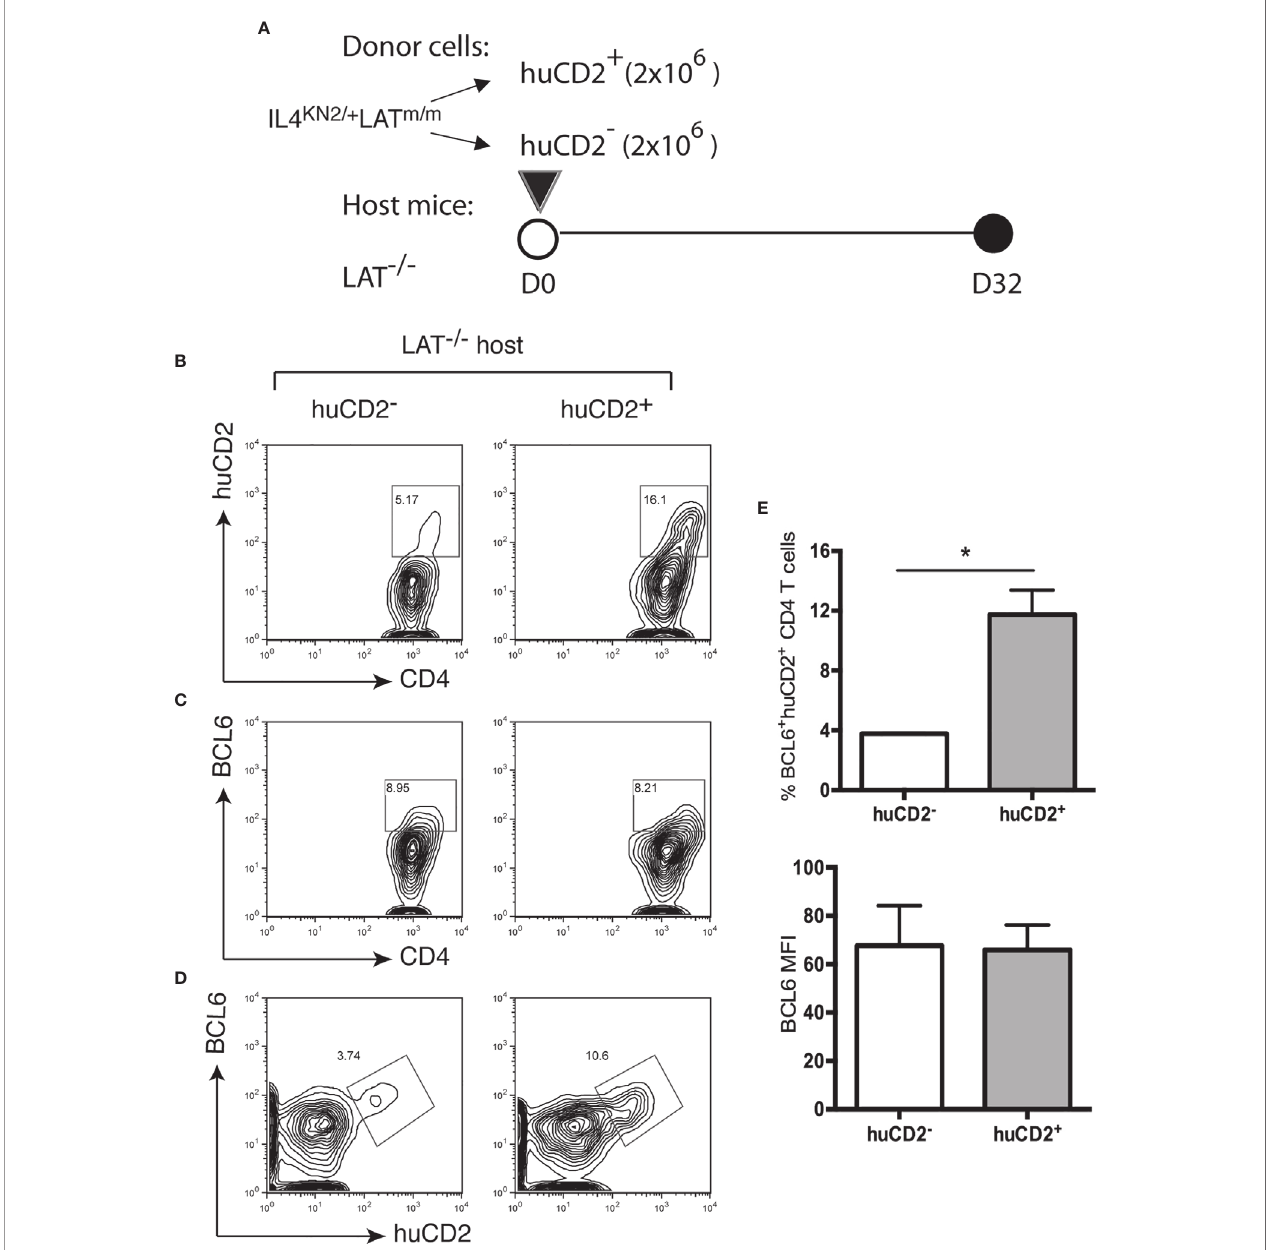
FIGURE 6 | Instability of the LATY136F Tfh signature. (A) 1.5x10 6 huCD2 + and huCD2 - CD4 + T cells were sorted from IL4 KN2+ LAT m/m mice and transferred into LAT -/- mice. Mice were sacri fi ced 8 weeks later and analyzed by FACS. CD4 and Thy1.2 were used to pre-gate on transferred T cells. (B) Representative fl ow plots of CD4 verse huCD2. (C, D) Intracellular staining for BCL6. (E) The percent of BCL6 + huCD2 + cells of total CD4 + T cells and BCL6 gMFI pre-gated on BCL6 + huCD2 + CD4 + T cells. Two-tailed t test; *p <